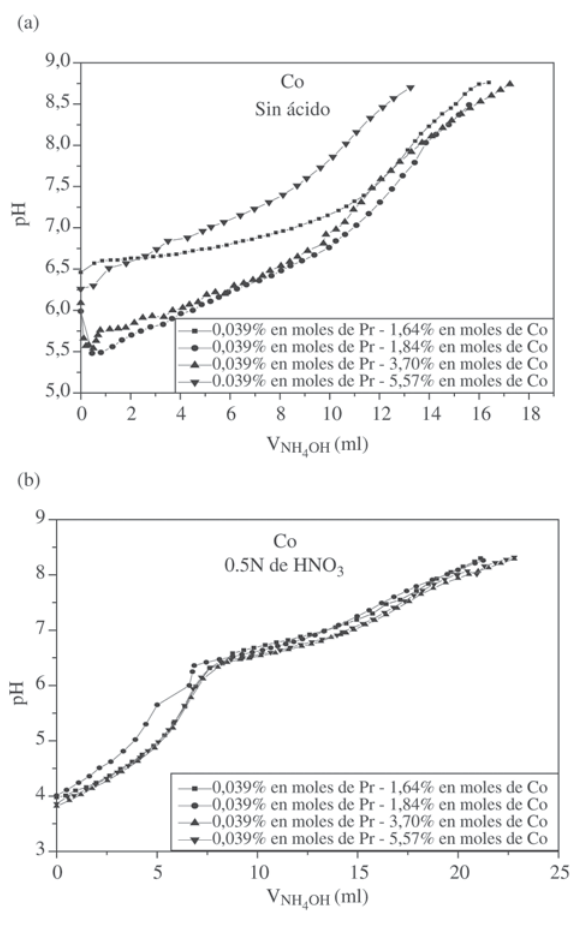
Figura 2. Curvas de valoración potenciométrica obtenidas para el sistema acuoso de cinc - praseodimio - cobalto, manteniendo el contenido de praseodimio constante - 0,039% en moles, sin ácido (a) y con ácido